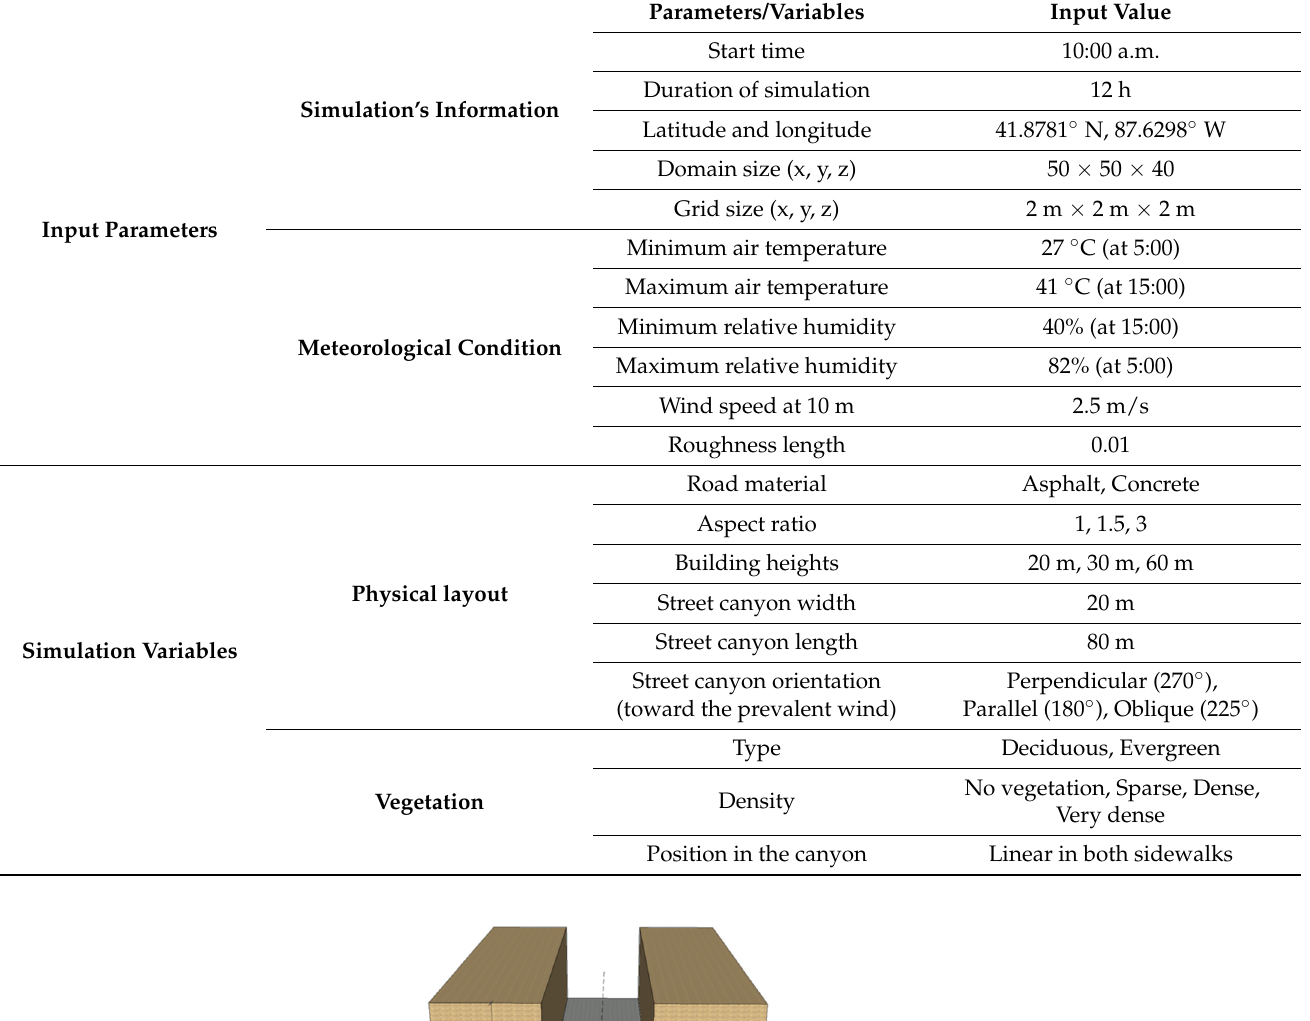
Table 1. Input values for each parameter in ENVI-met model.